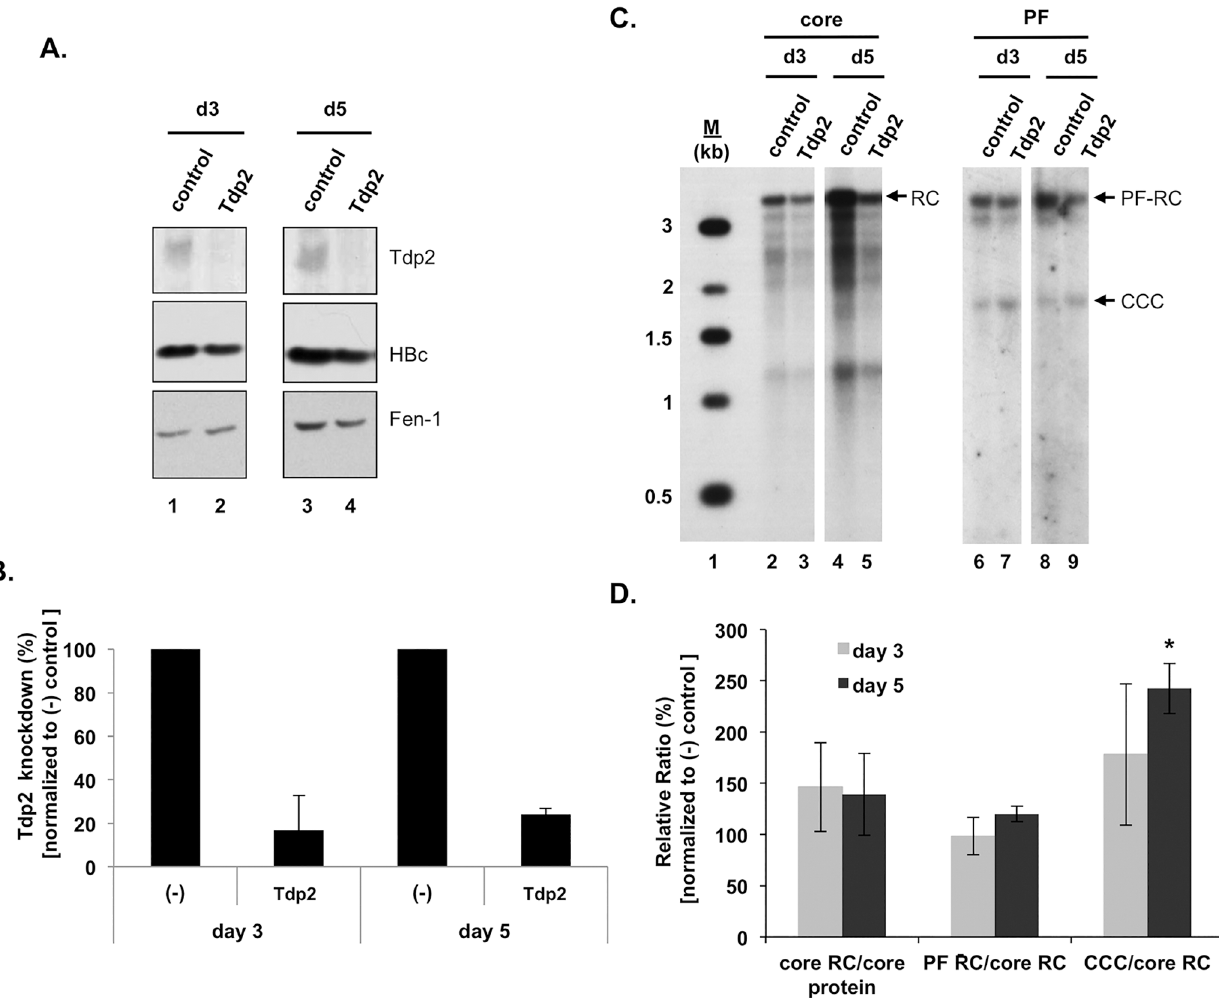
Fig 3. Knockdown of Tdp2 was associated with an increase in HBV CCC DNA. HBV replication was induced in HepAD38 cells by removal of tetracycline from the culture medium. Cells were transfected 4 days after tetracycline removal with control (Non-target) or Tdp2-specific siRNA. Viral DNA levels were measured 3 and 5 days post-siRNA transfection. (A) Tdp2 and HBV core protein levels were measured by western blot analysis. Fen-1 was used as a loading control. (B) Percent Tdp2 knockdown at day 3 and 5 post-siRNA transfection relative to control siRNA knockdown (set to 100%). (C) HBV DNAs were extracted from the cytoplasmic nucleocapsid (core) with protease digestion or the Hirt supernatant without protease digestion (PF) and analyzed by Southern blotting. (D) Quantitative analysis of HBV DNA replication. The indicated viral DNA ratios following Tdp2 knockdown were normalized to the corresponding DNA ratios after control (Non-target) treatment (set to 100%) and are reported as the mean relative ratios ± standard error of the mean of three independent experiments. The asterisk indicates a significant difference in Tdp2 knockdown CCC/core RC compared to control conditions at day 5 post-siRNA transfection (P < 0.05; unpaired, two-tailed t-test). CCC, CCC DNA; PF-RC, PF-RC DNA; RC, RC